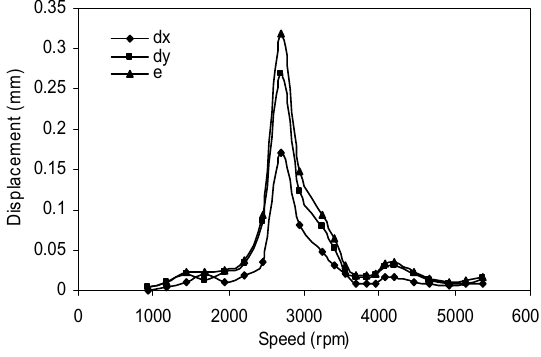
Fig. 4. Speed – Displacement relation for simply supported shaft (mild steel shaft of 0.7 m length).